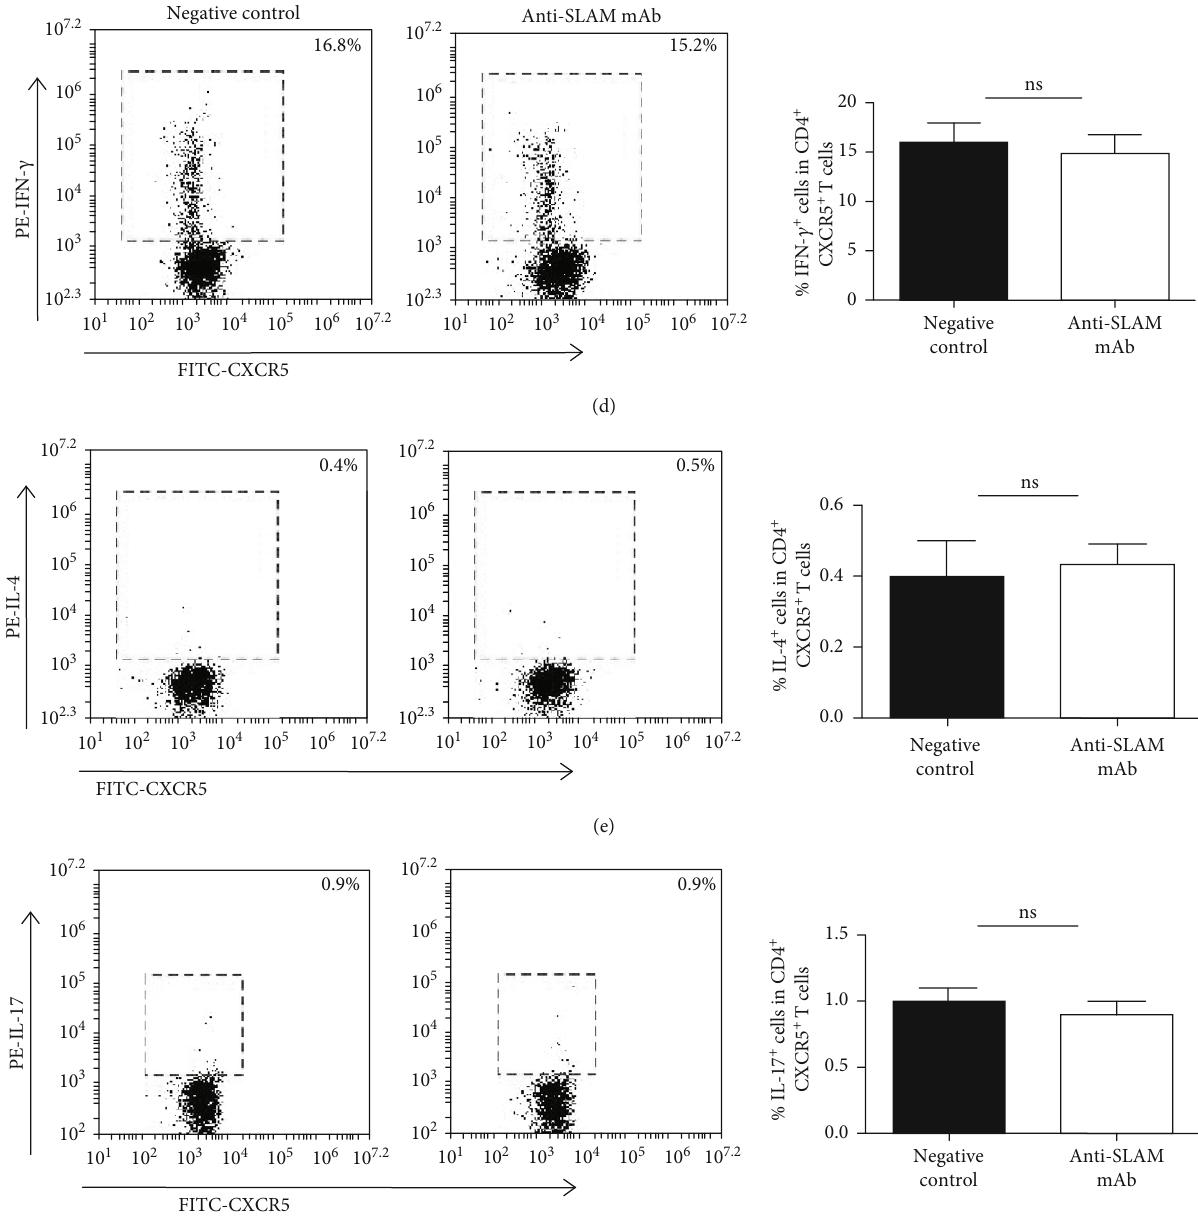
Figure 2: The role of SLAM on circulating CD4 + CXCR5 + T cells. Addition of 0.5 μ g/ml anti-CD3 mAb and 2 μ g/ml anti-SLAM mAb to CD4 + CXCR5 + T cells, followed by determination of the percentage of (a) Foxp3 + cells, (d) INF- γ + cells, (e) IL-4 + cells, and (f) IL-17 + cells. (b) Addition of 0.5 μ g/ml anti-CD3 mAb and 2 μ g/ml anti-SLAM mAb to CD4 + T cells and detection of the percentage of Foxp3 + cells. (c) Addition of 0.5 μ g/ml anti-CD3 mAb with 0.125 μ g/ml, 0.5 μ g/ml, and 2 μ g/ml anti-SLAM mAb to CD4 + CXCR5 + T cells and detection of the percentage of Foxp3 + cells. Each experiment was repeated three times; ∗∗ P < 0 : 01 ; ∗ P < 0 : 05 ; ns: no signi fi cant di ff